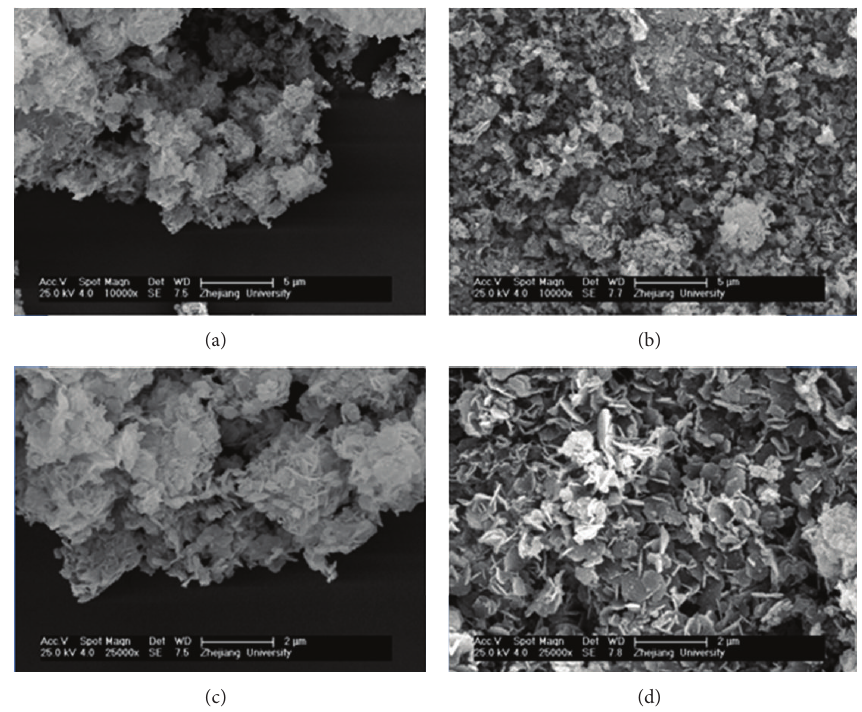
Figure 3: SEM images of Co 𝑥 Mg 6−𝑥 Mn 2 LDH precursors (a) and (c), 𝑥 = 4.5, and (b) and (d), 𝑥 = 6.